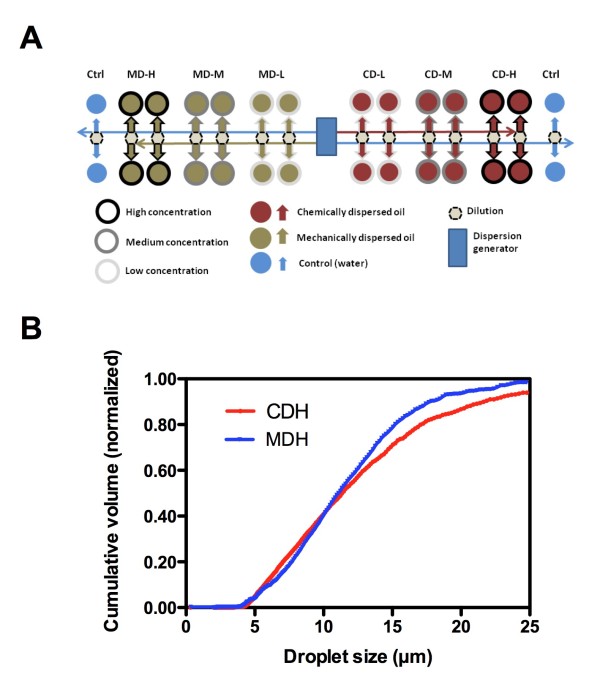
A) Schematic diagram of the experimental design. For both mechanically dispersed (MD) and chemically dispersed (CD) oil, 3 concentrations – low (L), medium (M) and high (H) – were used (n = 4 for all). Dispersions were made using two dispersant generators where oil-in-water-dispersions were generated from either oil premixed with dispersant, or from oil alone. Dilution of the dispersions was computer controlled using solenoid vales to collect defined ratios of dispersions and clean seawater from the two feed tubes running along the exposure chambers. A total of 4 control chambers were used. B) Cumulative size distribution based on volume of oil droplets recorded at the outlet of the high exposure vessels with mechanically and chemically dispersed oil. Data in each group are average of 4 parallel vessels. Algae with mean size of 4.7 μm have been subtracted.